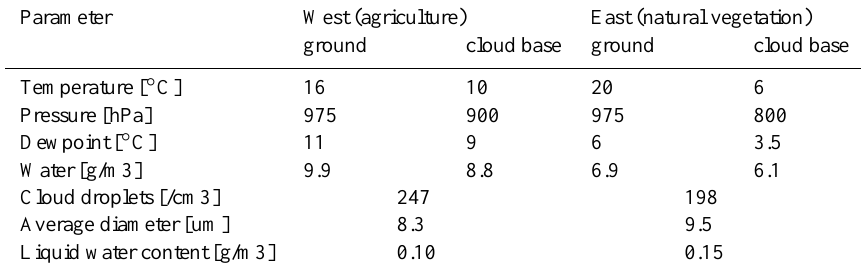
Table 1. Meteorological and cloud physics parameters below (ground and cloud base) and within